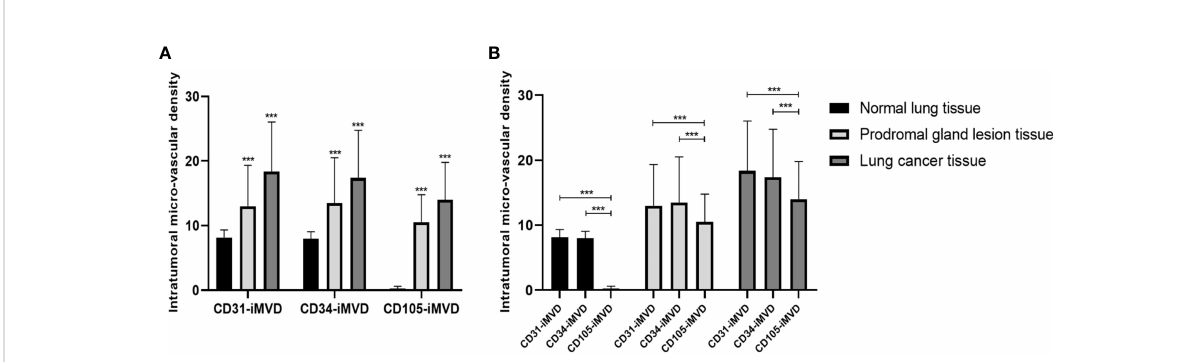
FIGURE 4 Interrelationships between the iMVD marked by immunohistochemical staining of CD31, CD34, and CD105 and GGN pathology types. (A) The values of CD31-iMVD are similar to CD34-iMVD, and their values are all higher than CD105-iMVD, suggesting that CD105-iMVD has a higher speci fi city than CD31-iMVD and CD34-iMVD. (B) With the increase of malignancy, CD31-iMVD, CD34-iMVD and CD105-iMVD have been signi fi cantly improved, indicating that they are sensitive indicators of the degree of tumor malignancy. ***indicates signi fi cance values